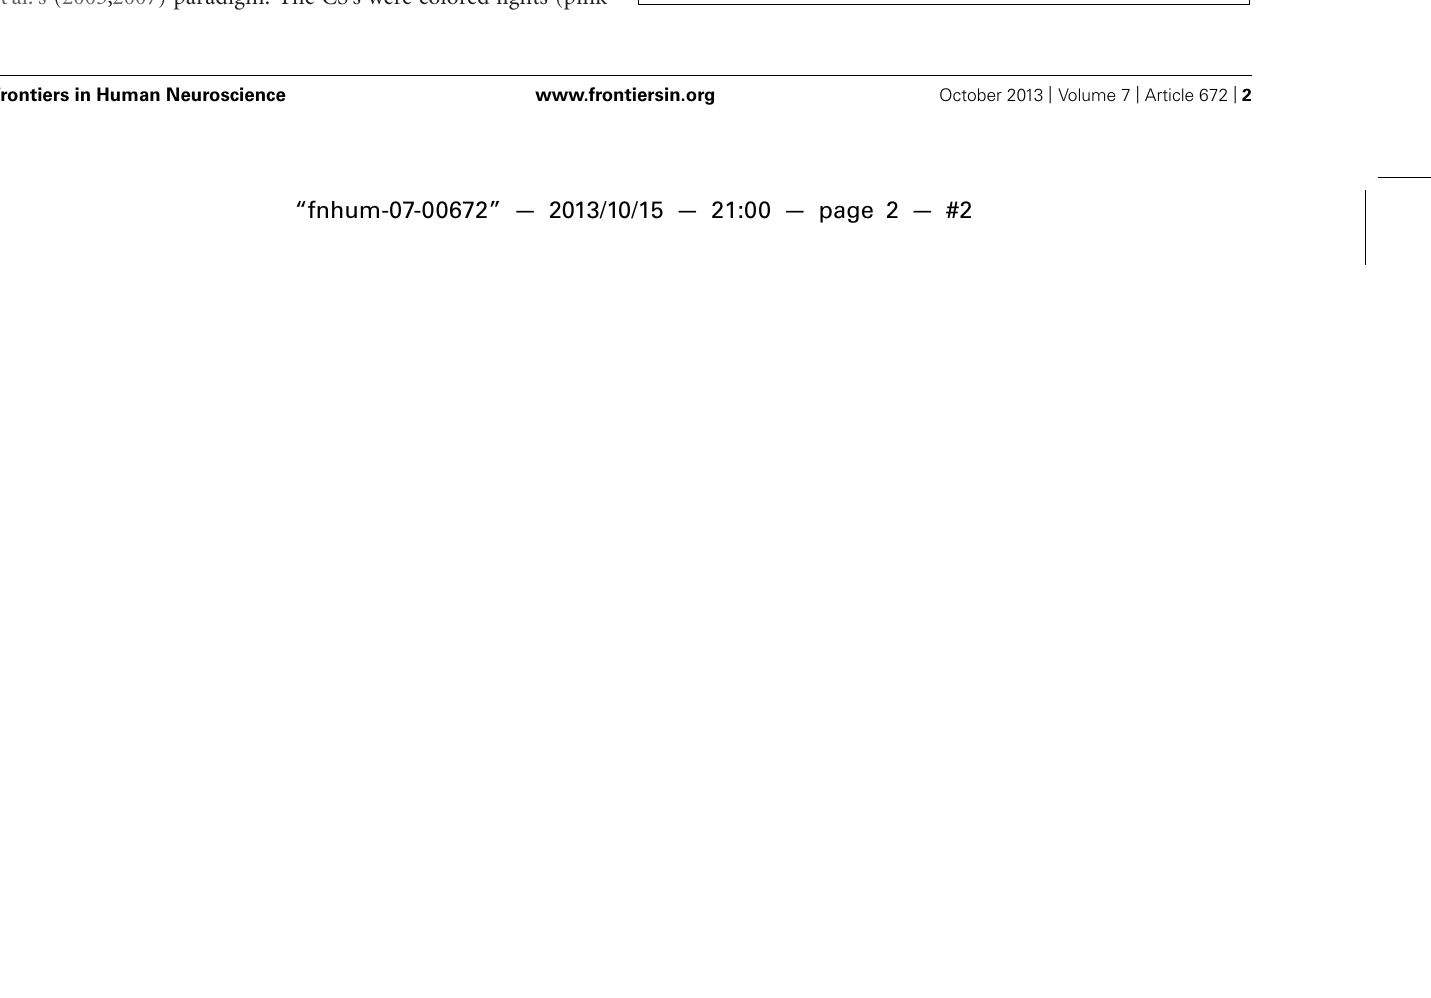
FIGURE 1 | Fear conditioning and extinction procedures . Fear condi- tioning contingencies were established during acquisition, followed by extinction of the CS + (to form CS +